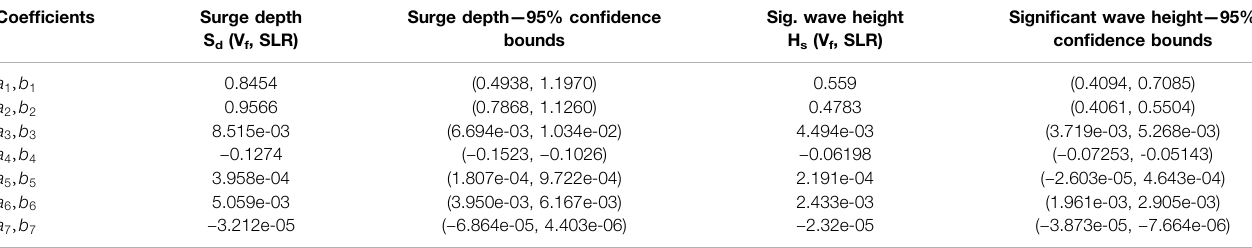
TABLE 1 | Coef fi cients of the polynomial regression model and 95% con fi dence bounds for surge depth and signi fi cant wave height. Coef fi cients